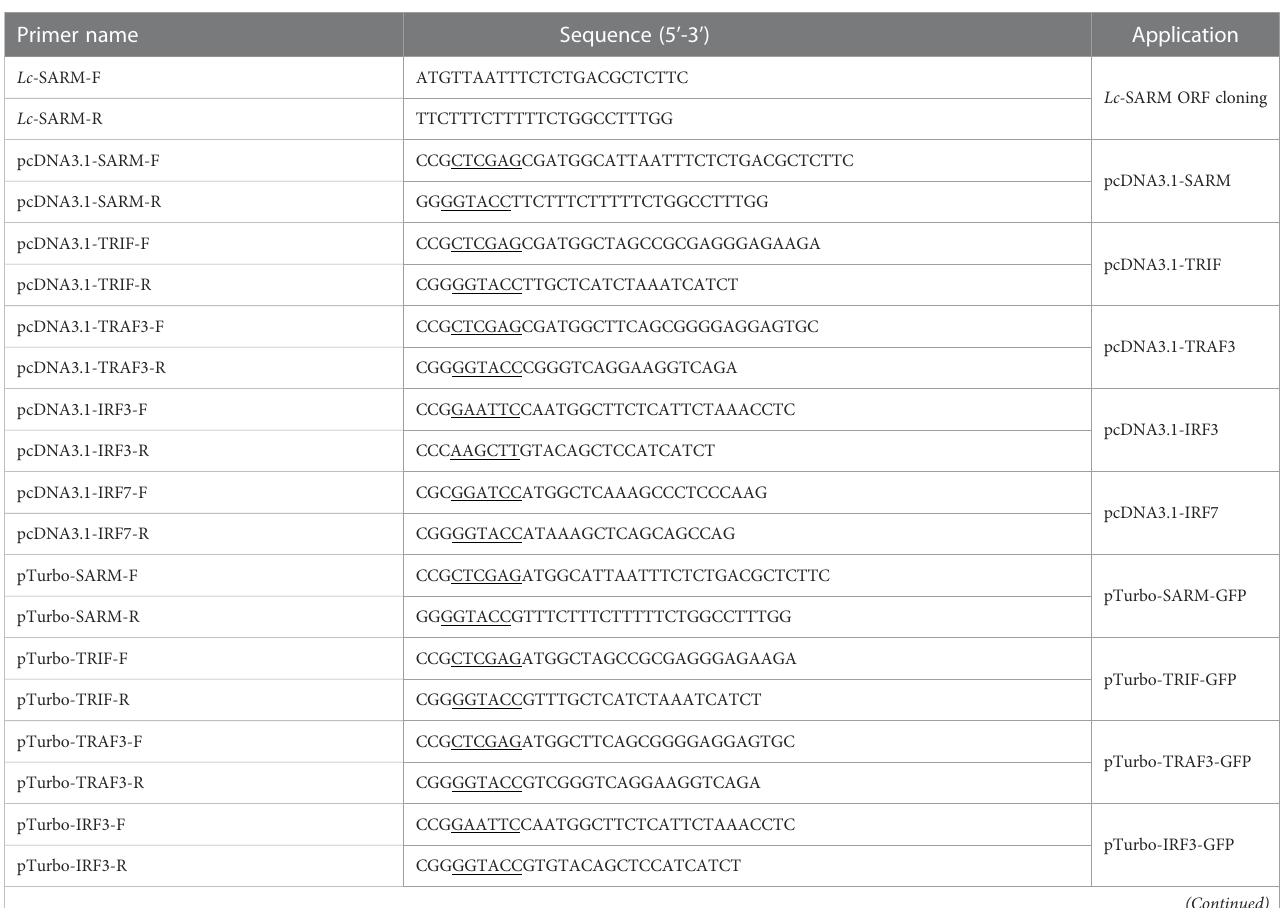
TABLE 1 Primer sequences used in this